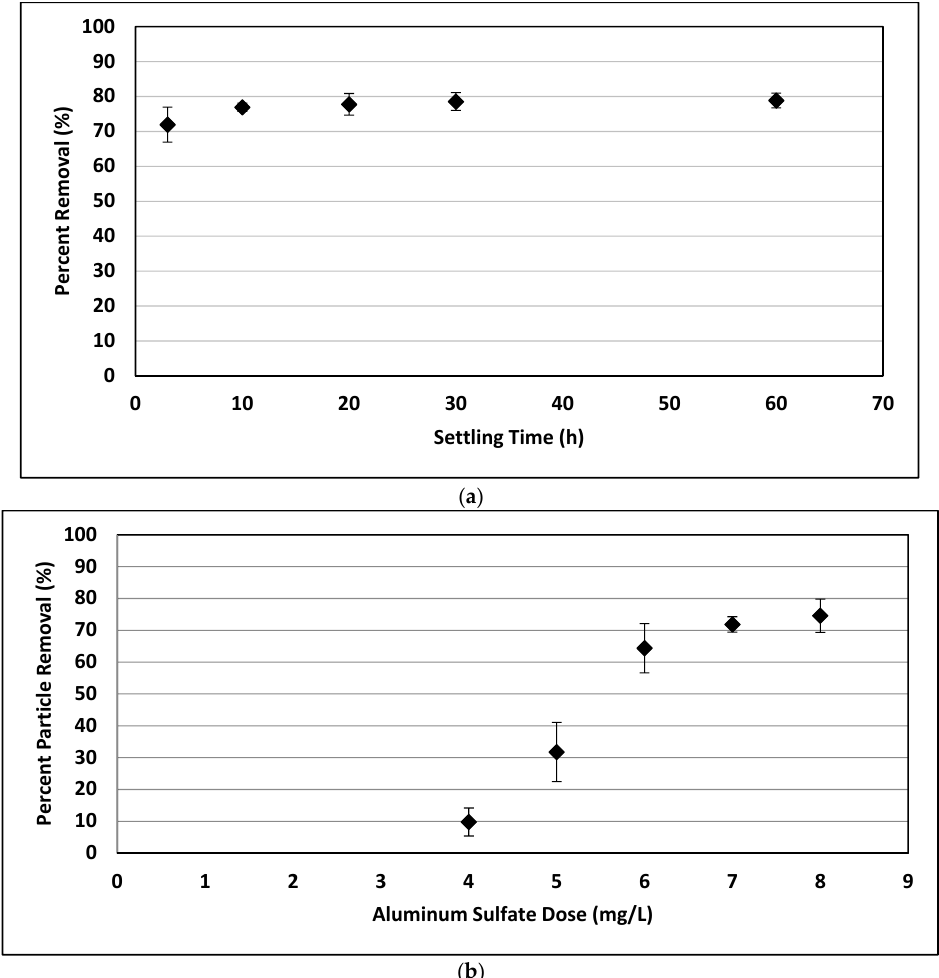
Figure 7. Percent removal of nanoplastics by gravity settling based on turbidity measurements (initial concentration = 5 mg/L).